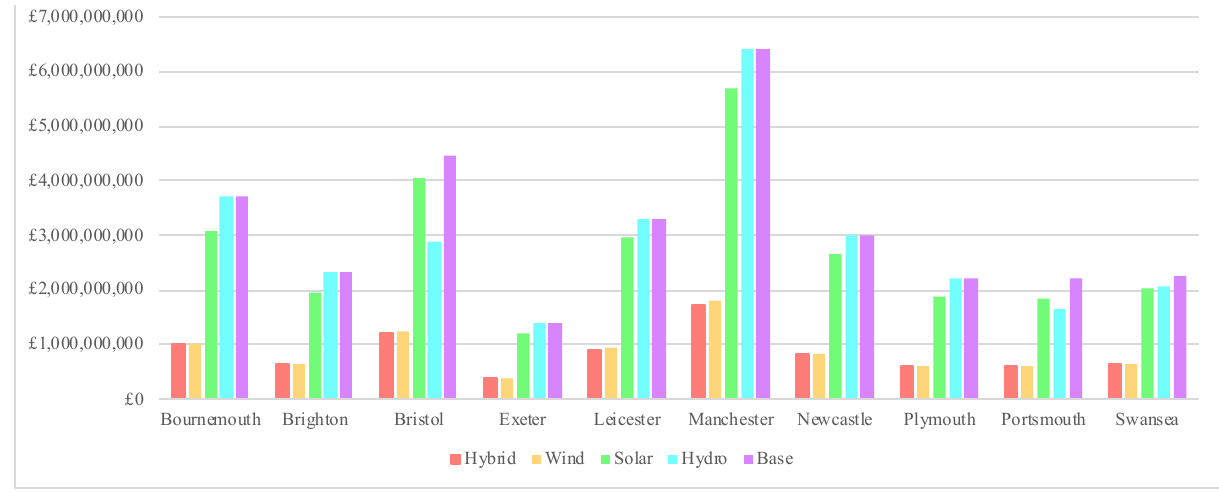
Figure 13. Net Present Cost comparisons between systems.